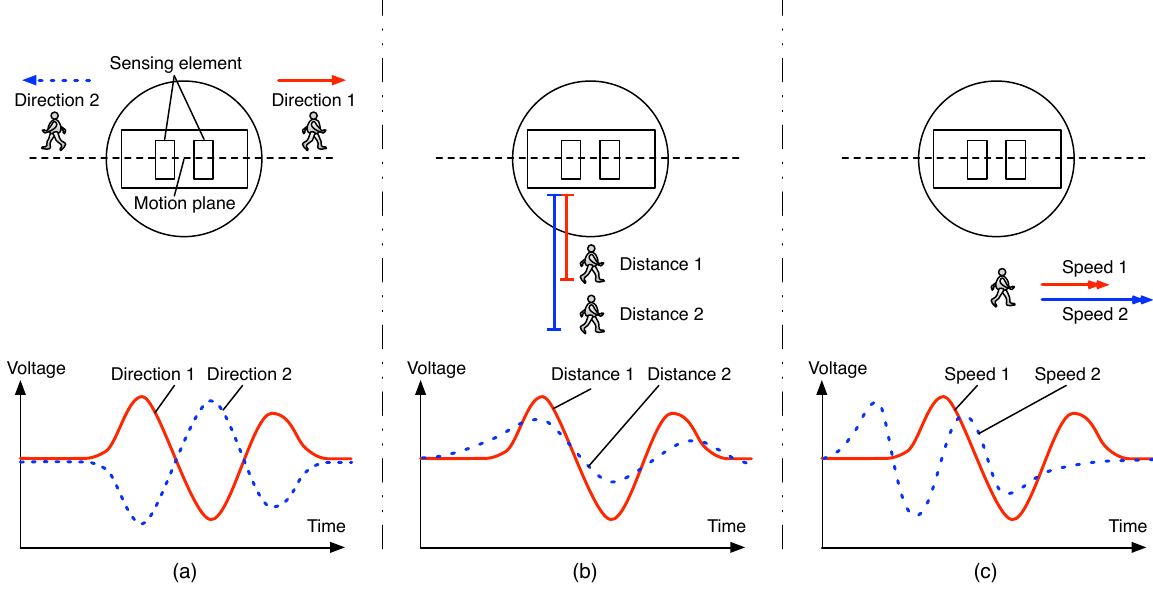
Figure 2. A schematic presentation of a pyroelectric infrared (PIR) sensor with dual sensing elements aligned in a motion plane and its output signal when walking: ( a ) the output signal in the case of walking in different directions; ( b ) the output signal in the case of walking at different distances; ( c ) the output signal in the case of walking at different speed